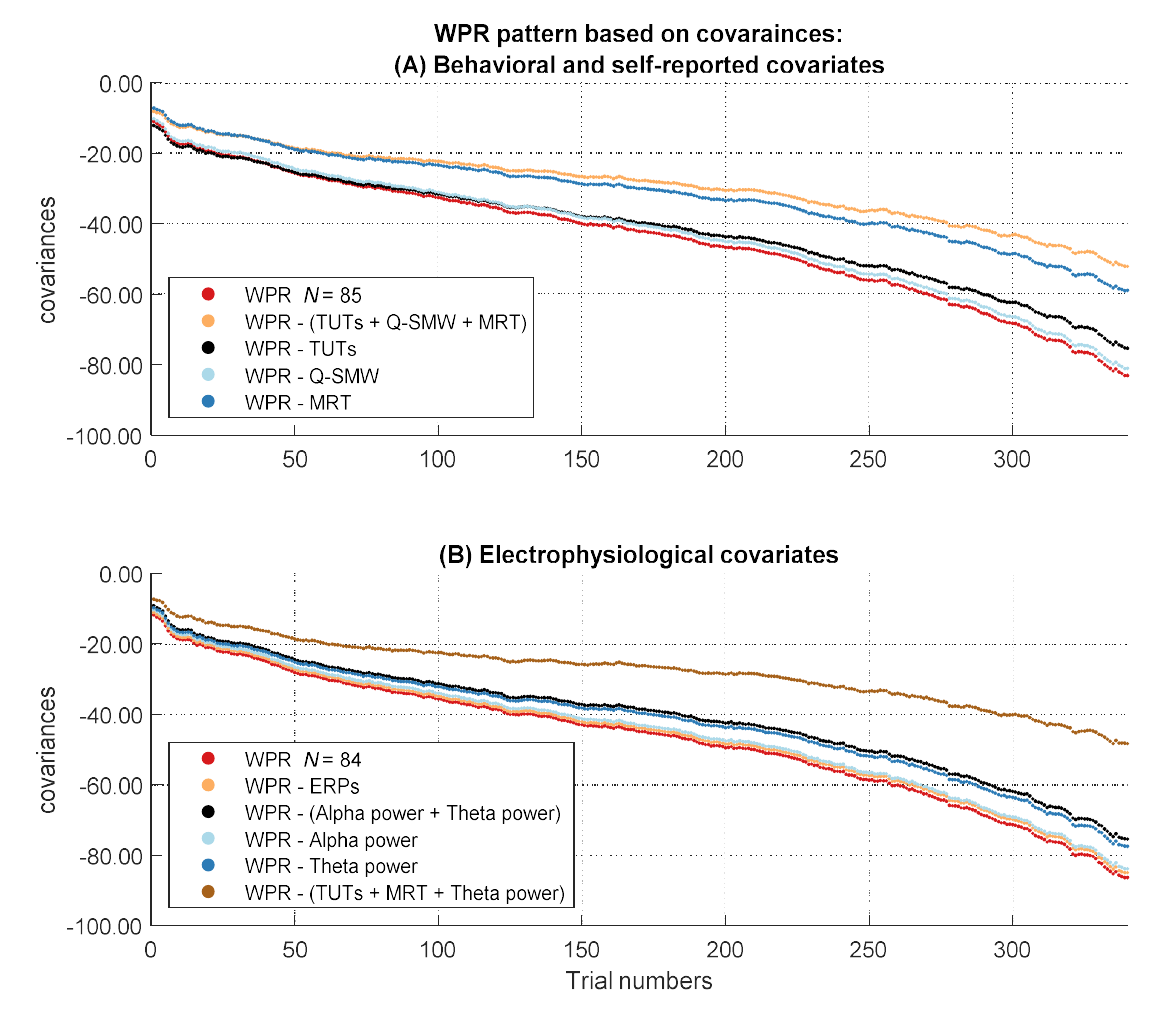
Figure 4. Course of the covariances over the RT distribution before and after controlling for the influence of the attentional lapses covariates. The figure describes the worst performance pattern in covariances before (red lines) and after (other lines) the different covariates or their combinations were partialized out of the RT variable (labeled in the boxes on the side of the dashes in the figure legend). ( A ) shows the results of the behavioral and self-reported covariates in the full sample of N = 85. ( B ) shows the results of the electrophysiological covariates in the subsample of N = 84.